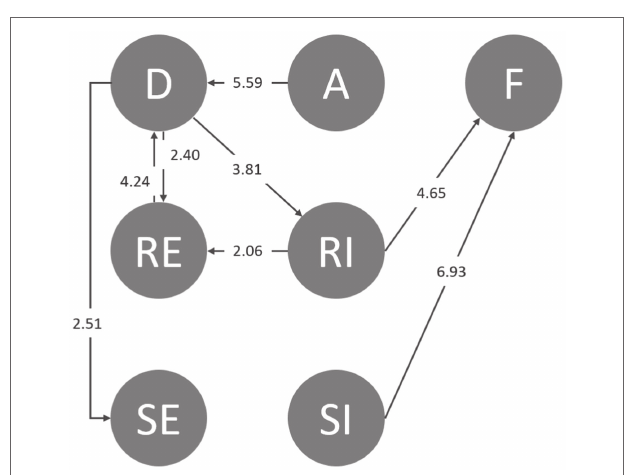
FIGURE 5 | The behavioral transition diagram after using the serious game- based situational learning system.